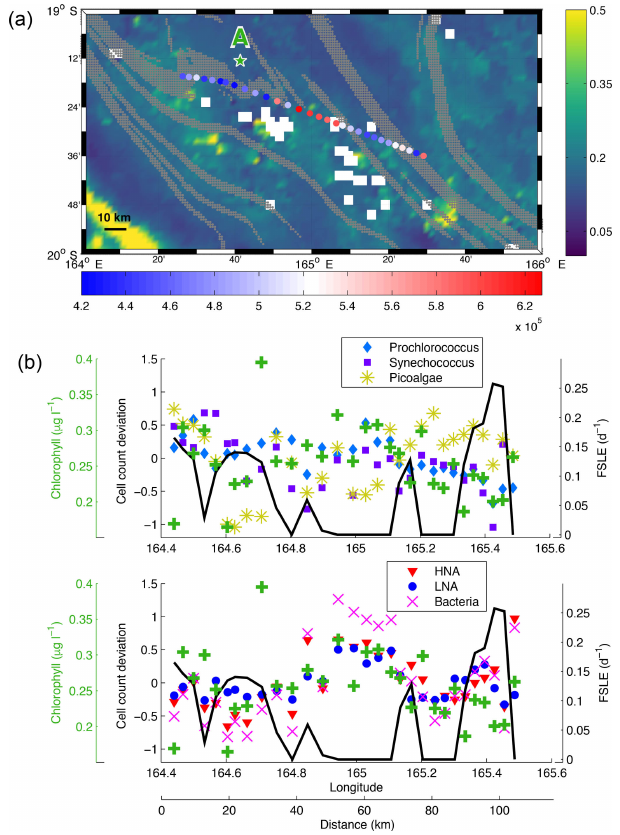
Figure 8. (a) Chlorophyll concentration (mgm − 3 , colour bar) from 3 March 2015 superimposed with bacteria counts (cellmL − 1 , red-blue colour bar) sampled during LDA. FSLE fronts (val- ues > 0.05day − 1 ) are shown in grey. The location of LDA is in- dicated with the green star. White squares are missing satellite data due to cloud cover. (b) Cell count deviation (see Sect. 2.1) of Prochlorococcus , Synechococcus , PPEs and bacteria (HNA and LNA) superimposed with FSLE values (day − 1 , black line) and sur- face chlorophyll concentration (µgL − 1 , green crosses) along the high-frequency transect of